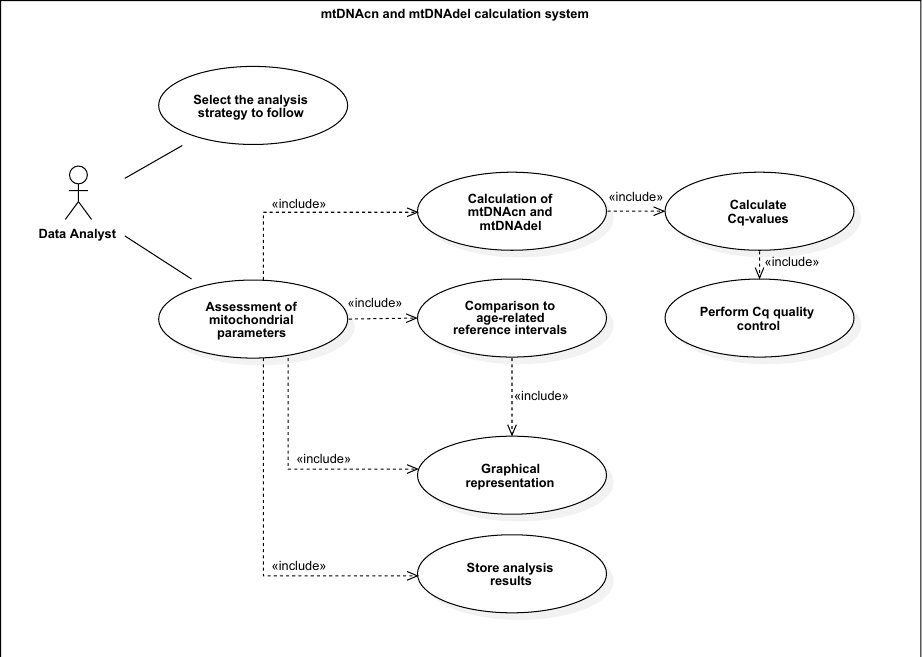
Figure 1. Use case for extension of PlateFlow for mtDNA analysis.